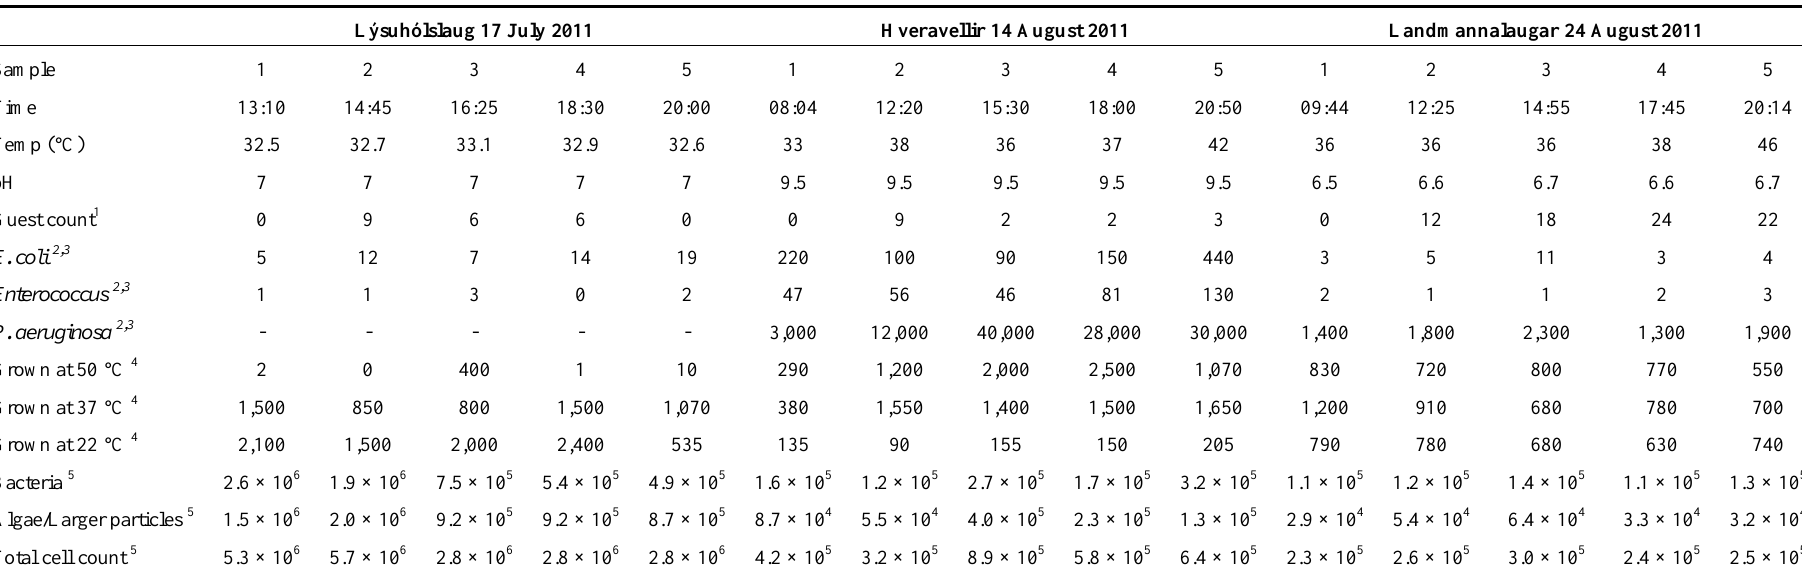
Table 1. Numbers of Escherichia coli , Enterococcus spp. and Pseudomonas aeruginosa , sampling time, temperature, pH, guest count, total bacterial counts at cultivation and total cell counts by flow cytometry in samples from each